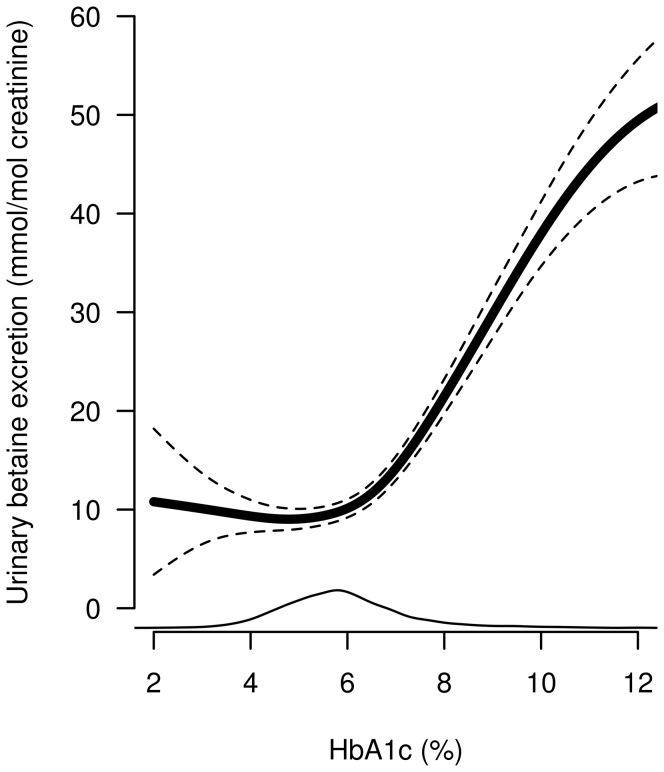
Generalized additive model showing the non-linear association between urinary betaine excretion and glycated hemoglobin (HbA1c).The dotted lines mark the 95% confidence interval. The line at the bottom indicates the distribution.